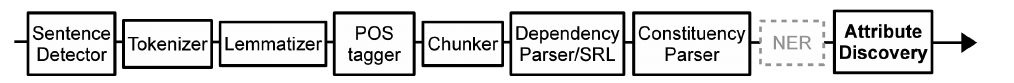
Figure 1. The cTAKES Pipeline. The SHARPn Polarity Module is an Attribute Discovery algorithm. Training and evaluations use gold standard NEs (skip NER).